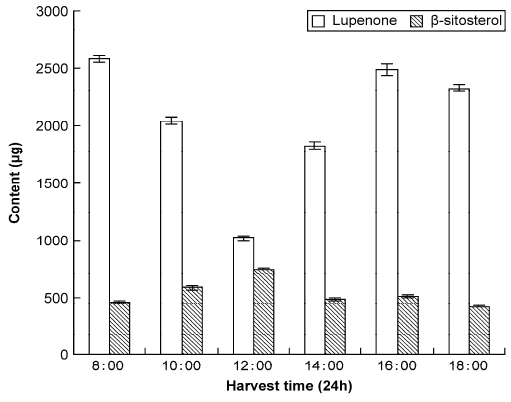
Figure 7. Levels of lupenone and β -sitosterol in Rhizoma Musae during different periods of the